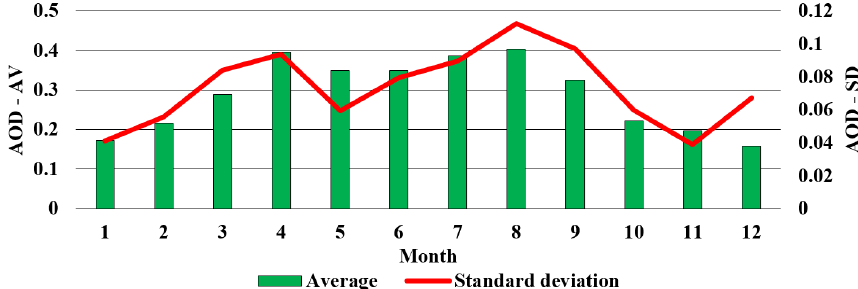
Figure 13. Average monthly characteristics of the AOD for the wavelength of 320nm,